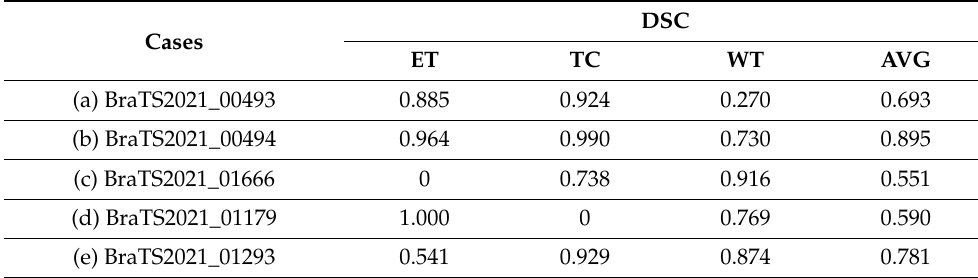
Figure 12. The visualized bad tumor segmentation cases of the proposed AABTS-Net. ( a – e ) represents different visualized cases. From left to right: T1, T2, T1c, Flair, Ground truth, the result segmented by AABTS-Net. Table 6. The DSCs of the bad segmentation